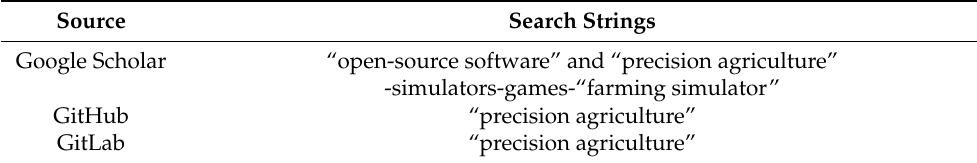
Table 2. Search strings used for each information source.